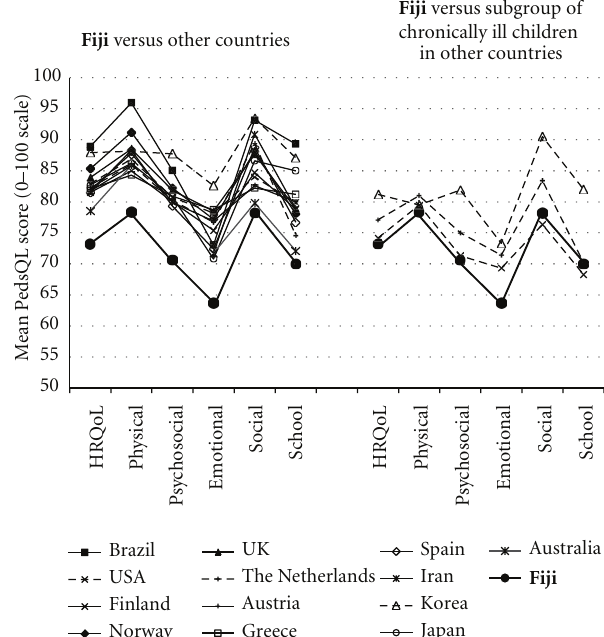
Figure 1: Comparison of self-rated health-related quality of life (HRQoL) and subdomains of HRQoL between community-based samples of school-aged children in Fiji and other countries. Self- rated HRQoL is also compared between the children in Fiji and subgroups of chronically ill children (parent reports) in three countries, namely, USA, Netherlands, and Korea. HRQoL is measured by the PedsQL in all samples. Adapted from